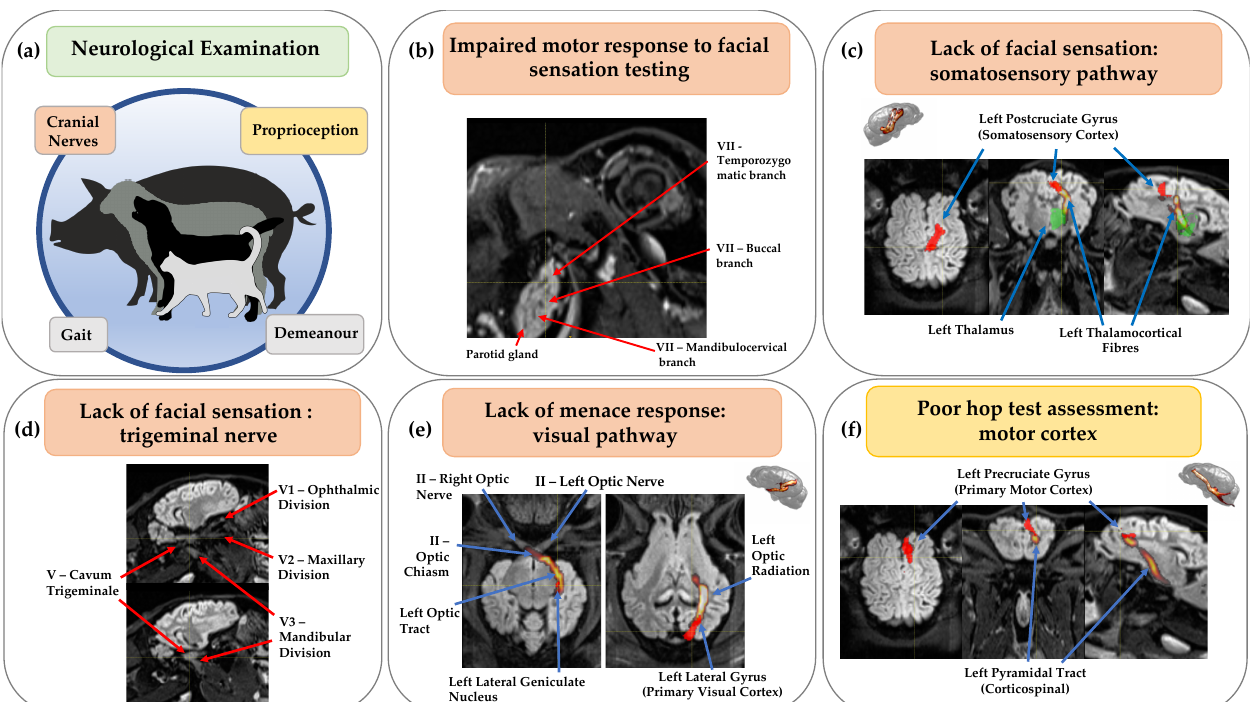
Figure 3. Use of MRI to enable detection of lesions in any part of the reflex pathway, and can be scored or quantified for statistical analysis alongside clinical scoring results. Examples of clinically relevant neuroanatomy from a healthy sheep (Ovis aries). ( a ) Initial neurological assessment by species specific expert identifies abnormalities in cranial nerve and proprioception exams. ( b ) MRI analysis can then determine whether any lesions or abnormalities are present e.g., cranial nerve VII (facial nerve) when facial motor function is impaired in isolation. If facial motor function is intact, but facial sensation is impaired, investigation of the thalamus and somatosensory cortex ( c ) and trigeminal nerve branches ( d ) should be undertaken. ( e ) Abnormalities arising in any of the visual exams can be further scrutinised in the visual pathway to determine if lesions are localised in the optic nerve/tract or chiasm as well as the lateral geniculate nucleus and visual cortex. ( f ) Proprioceptive deficit(s) can also be further investigated with imaging of the spinal cord if the exam pinpoints to a specific region of interest and/or to the motor pathway. Cortical and subcortical regions of interest (ROI; solid red or green) are labelled in the native individual animal using an atlas and template-based approach. Probabilistic tractography is carried out using FSL BEDPOSTX and PROBTRACKX on diffusion-weighted imaging data using cortical and subcortical ROIs. Tract probabilities are shown with a heatmap. The left pyramidal/corticospinal tract, left somatosensory thalamocortical fibres, and left postchiasmatic optic pathway are shown, overlaid on selected orthogonal slices from a fat-saturated 3D FLAIR structural